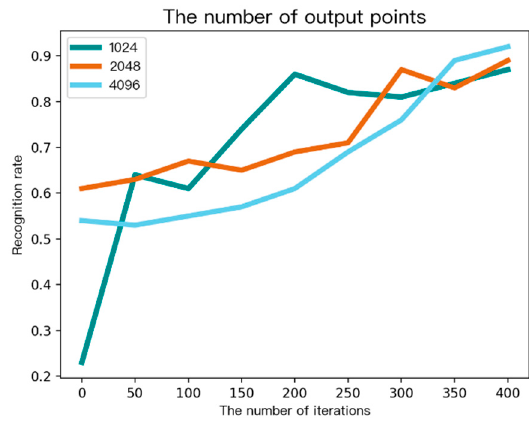
Figure 8. Recognition rate under different output nodes.